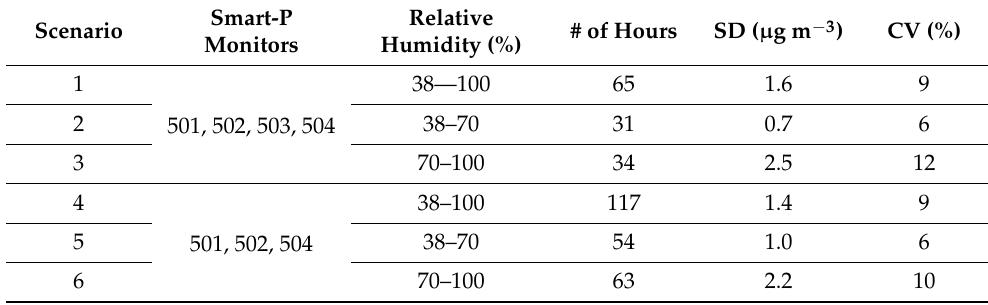
Table 2. Precision among multiple (3 or 4) Smart-P monitors during collocation measurements at Yale Coastal Field Station